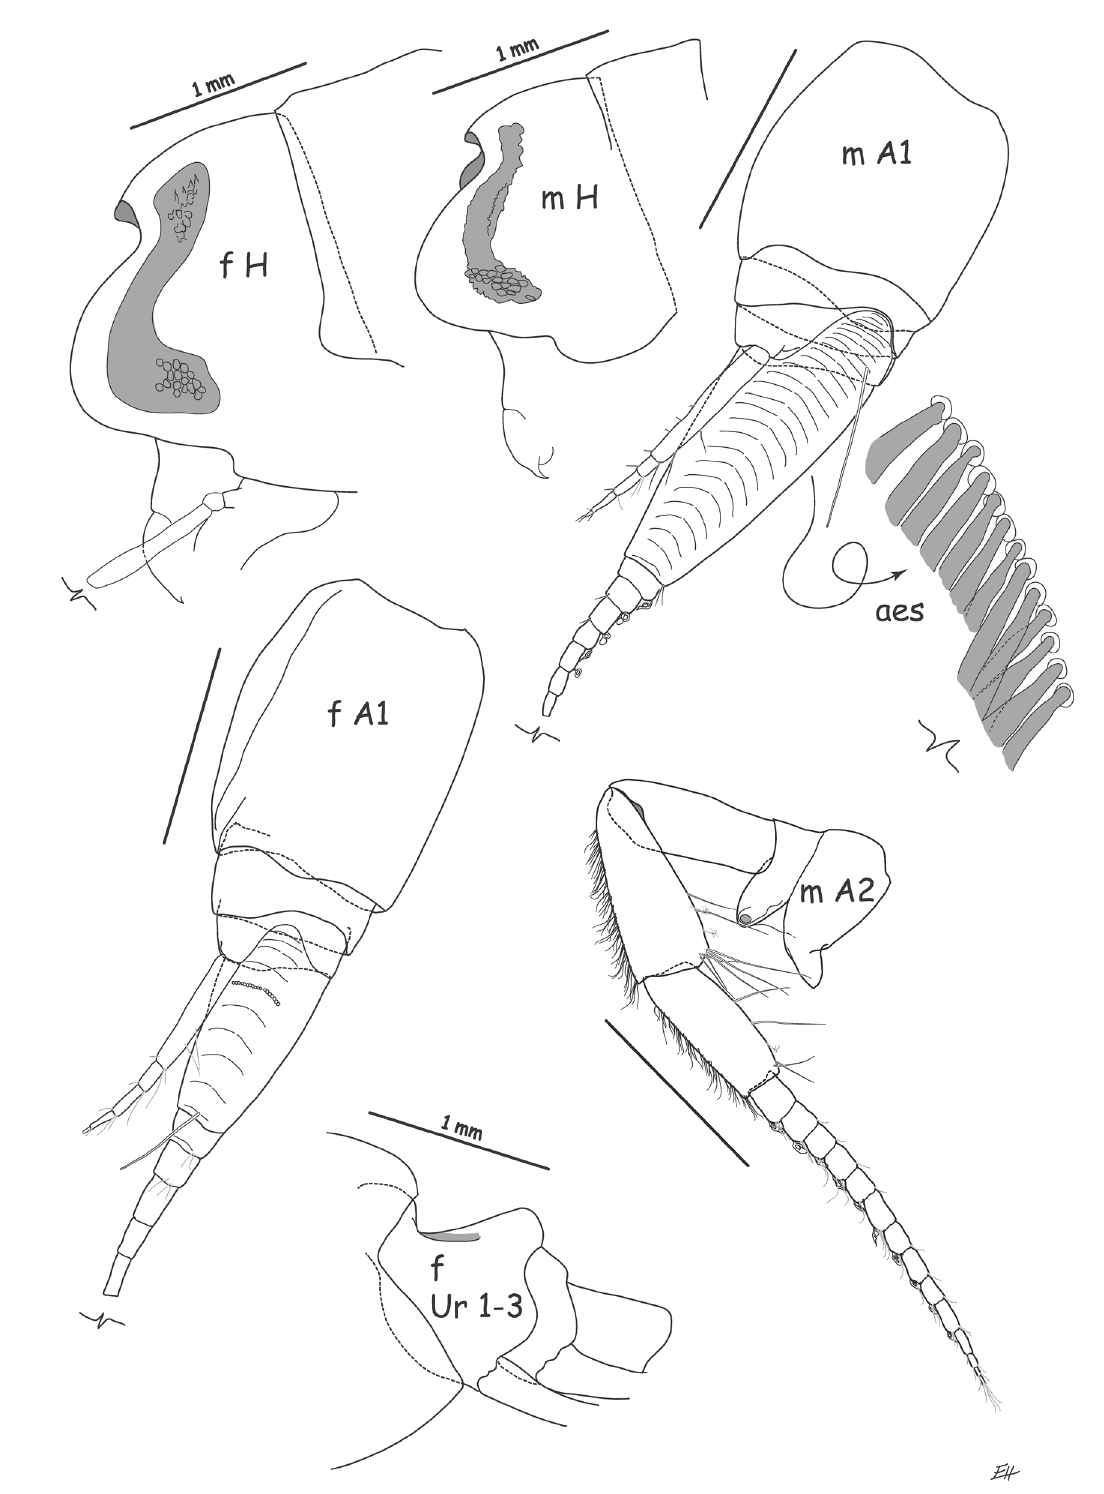
Fig. 11. Abyssorchomene patriciae sp. nov., holotype, ♀, 10.5 mm (NHM UK 2022.6); allotype, ♂, 7.5 mm (NHM UK 2022.7), RRS James Cook (2011), station JC 062-063, Northeast Atlantic, Porcupine Abyssal Plain, depth 4848 m, 8 August 2011. Aesthetascs omitted from A1 callynophore. End of flagellar articles missing on male and female A1. Scale bars = 0.5 mm unless indicated